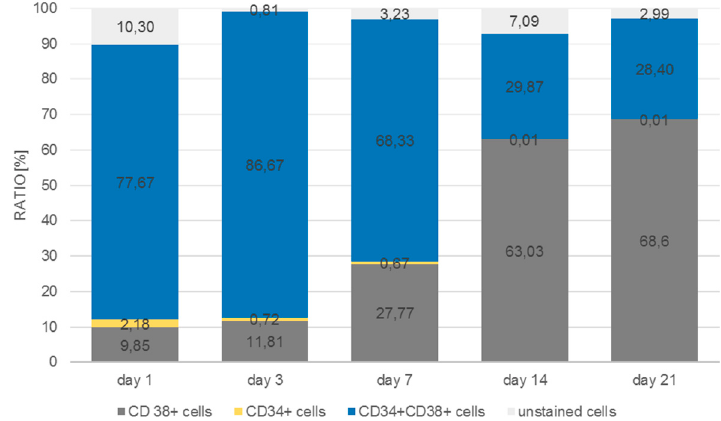
Figure 11. Distribution of CD34 + , CD38 + , CD34 + / CD38 + , and unstained cells in microcavities over a period of 21 days.